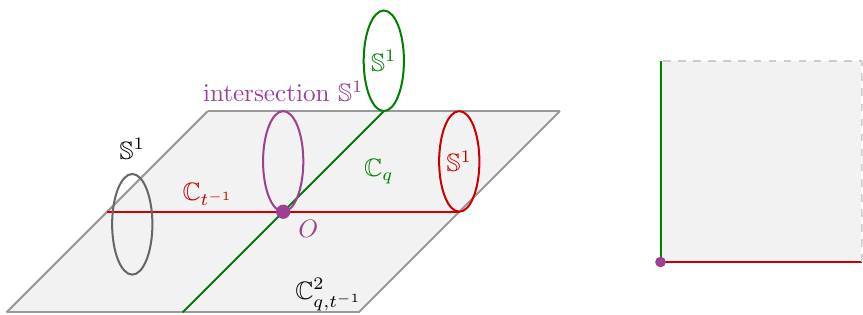
1 ) 1 ) as a subspace of C 2 1 . We note that the two ( C q (cid:2) S t (cid:0) 1 (cid:2) S q;t (cid:0) 1 (cid:2) S [ 2 actually intersect at the origin O . The bulk space C 2 S 1 t (cid:0) 1 (cid:26) C q;t (cid:0) 1 q;t (cid:0) 1 (cid:2) S 1 , while it reduces to S 1 and C t (cid:2) (cid:0) 1 (cid:2)